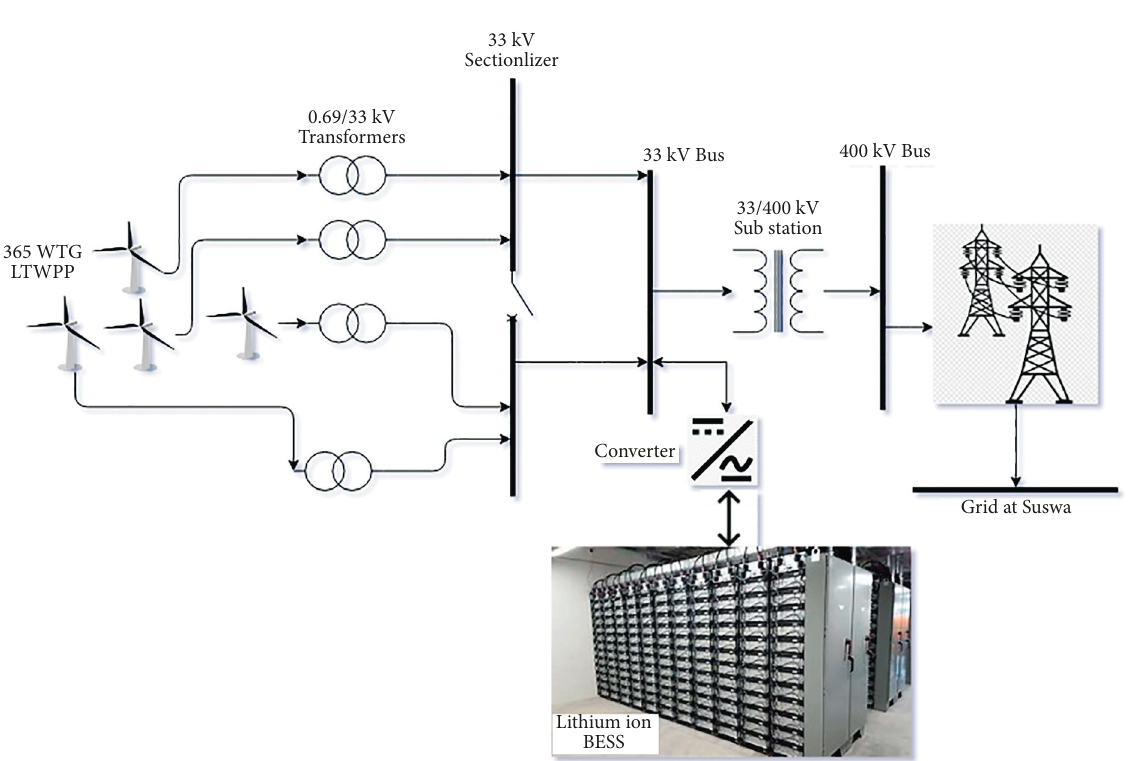
Figure 6: The topology of the LTWPP incorporated with